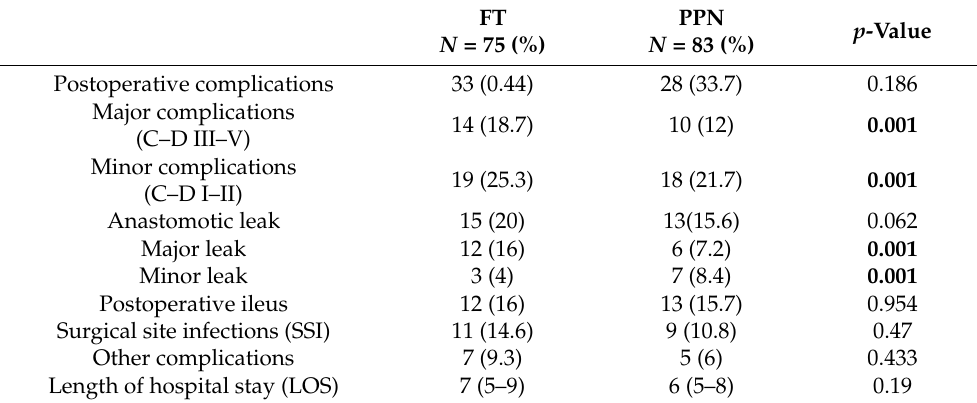
Table 3. Postoperative morbidity details for the whole group of patients.